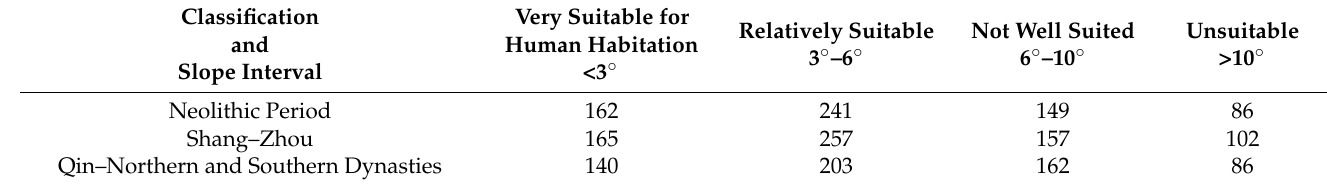
Table 3. Slope distribution of settlements in different periods.